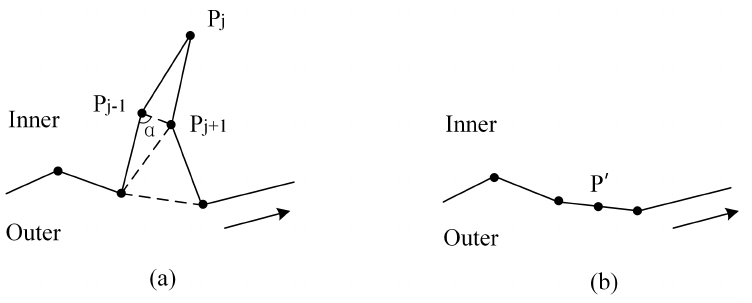
Figure 7. Treatment of bottom burrs: ( a ) before treatment; ( b ) after treatment, where P j , etc., in ( a ) represent the boundary discrete points, and P (cid:48) in ( b ) represents the midpoint of the line connecting discrete points on both sides of the